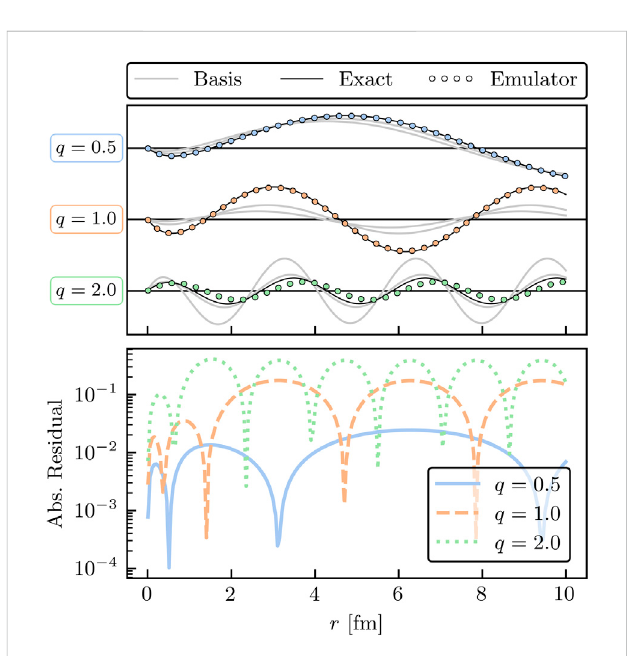
FIGURE 10 Wave functions (top panel) and absolute residuals (bottom panel) for the Yamaguchi potential Eq. 87 in arbitrary units using the constrained KVP. The top panel legend description is similar to Figure 9, but for three different values of q . The bottom panel shows the relative residuals of the three values previously